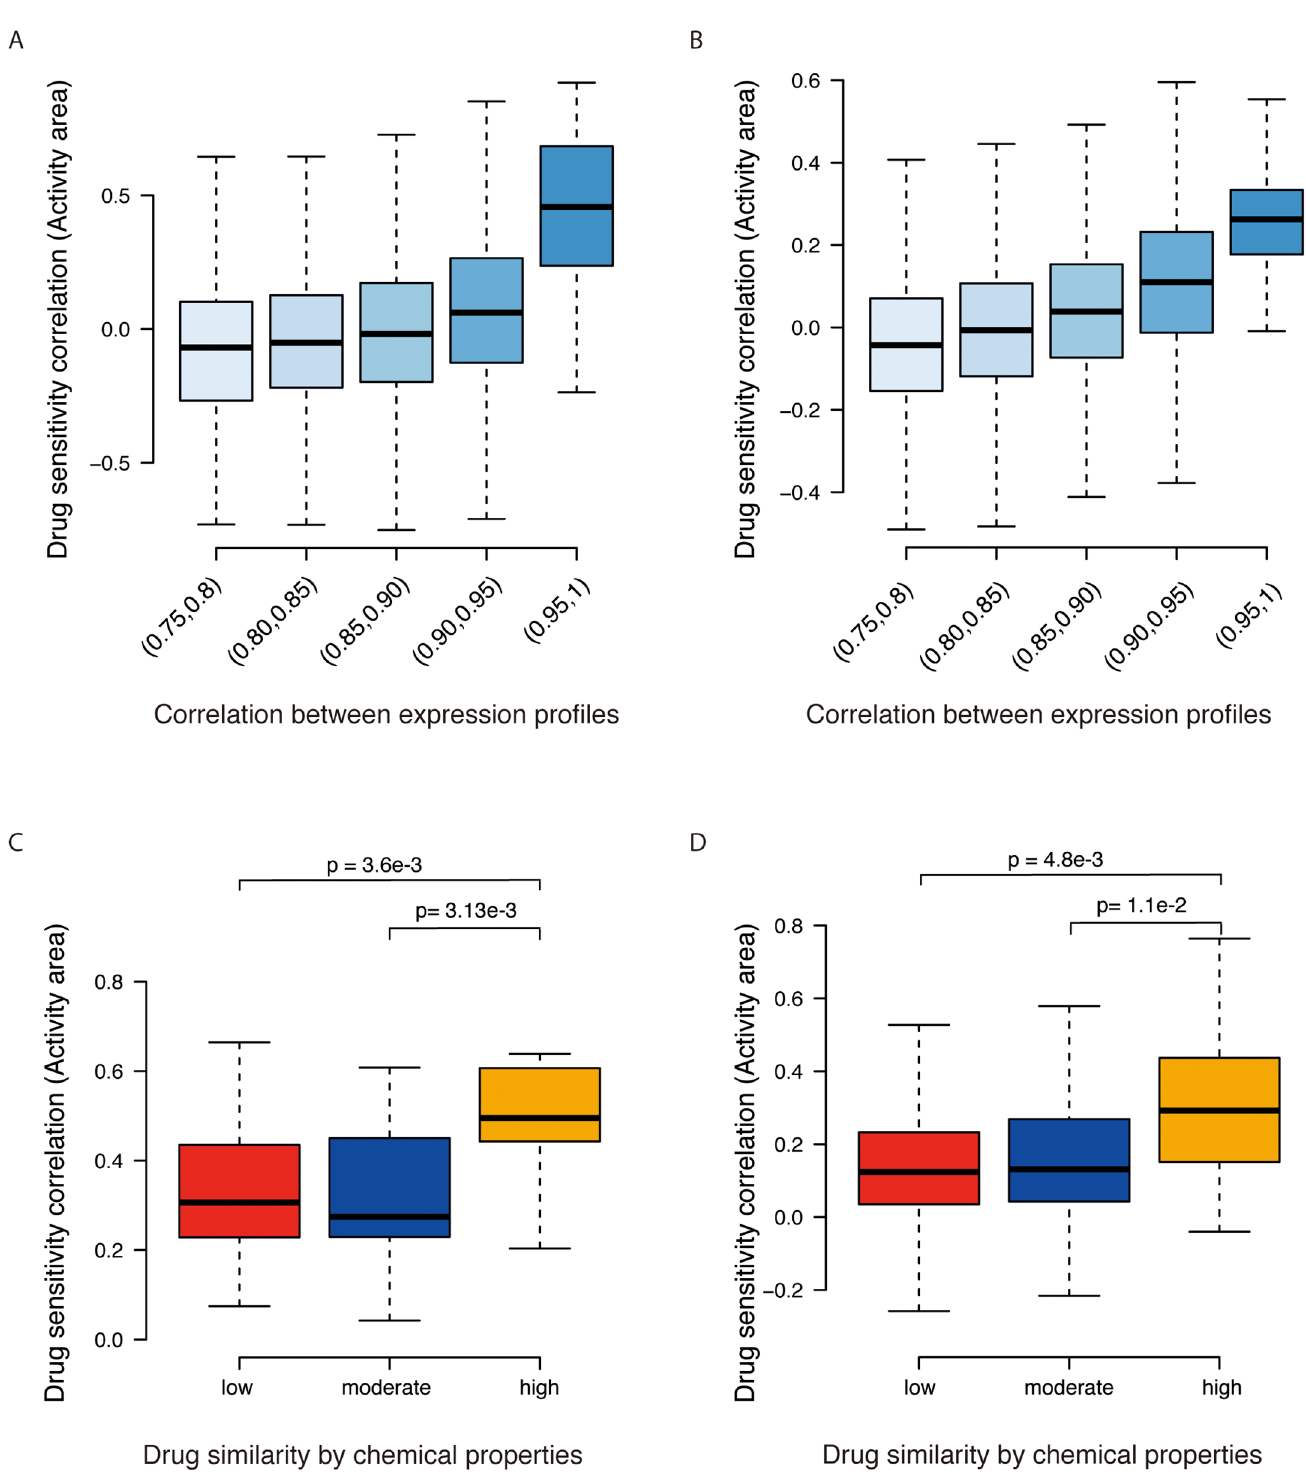
Fig 1. Model assumption. (A, B) Box plots showing cell lines with similar gene expression profiles responding similarly to the same drugs. The X-axis indicates the Pearson correlation coefficients between all possible cell line pairs based on expression profiles. The Y-axis shows the correlations of their drug response vectors as measured by activity area in CCLE (A) and CGP (B). (C, D) Box plots showing that drugs with similar 1-D and 2-D structural features based on PaDEL exhibiting similar effects on cell lines in the CCLE (C) and CGP (D) datasets. The X-axis represents the drug similarity categories, and the Y-axis shows the correlations of drug responses across all cell lines. Statistical differences between two groups were measured by the t-test.